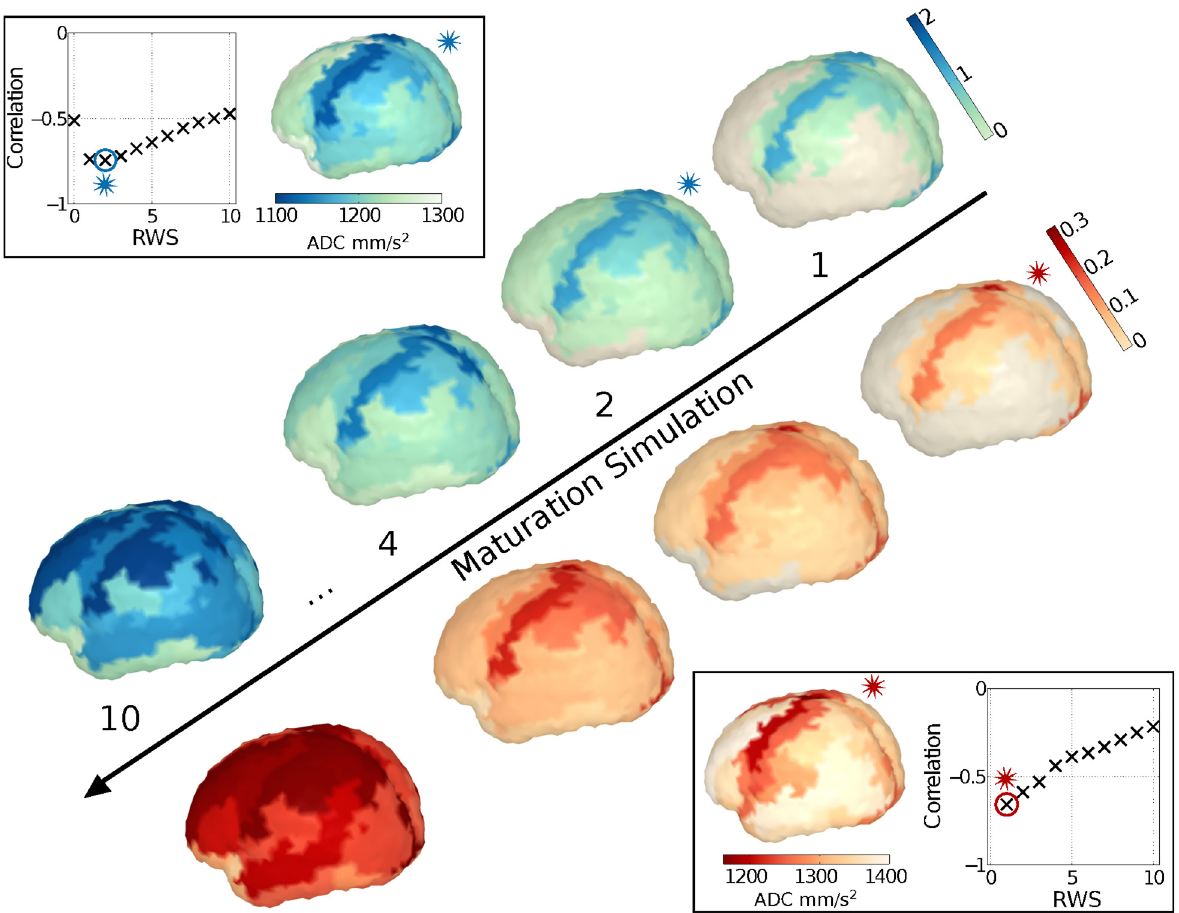
Fig 3. Modelled maturation scores projected on a standard brain surfacefor four representative simulated time points (RWSs): ROI in blue (top), connections in red (bottom). Box: Experimental data (ADC [10 − 6 mm/s 2 ]) on brain surface and Pearson’s correlationswith modelledmaturation scores for RWS 1–10. The RWS with the best correlationis represented by a star.